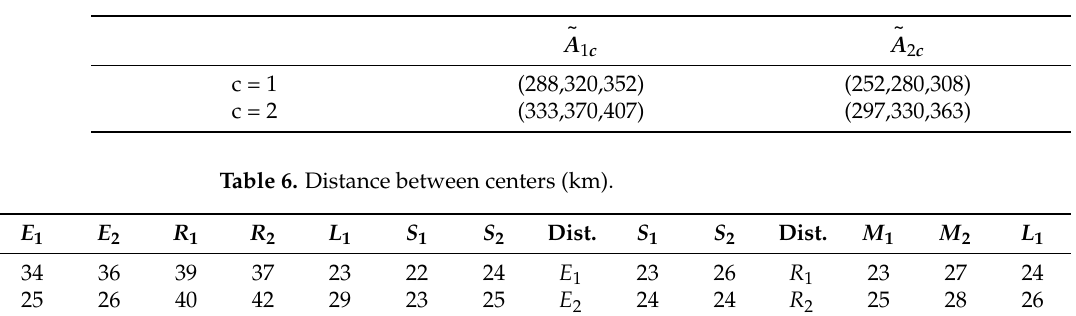
Table 5. The amount of used products at collection sites (unit).